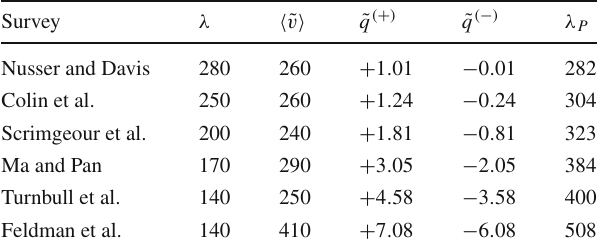
Table 1 Representative estimates of the deceleration parameter ( ˜ q – see Eq. (21)) measured in the rest-frame of the bulk flows reported in [21–26], with ˜ q ( + ) corresponding to slightly expanding and ˜ q ( − ) to slightly contracting bulk flows. In the latter case the peculiar Jeans length ( λ P – see last column) also marks the transition scale, where the sign of ˜ q ( − ) turns negative (see Eq. (22) and also Fig. 3). Note that both λ and λ P are measured in Mpc, while the mean bulk velocity ( given in km/s. Also, in all cases, the background universe is assumed to decelerate with q = + 0 . 5. Finally, we have set H (cid:3) 70 km/sMpc and λ H = 1 / H (cid:3) 4 × 10 3 Mpc